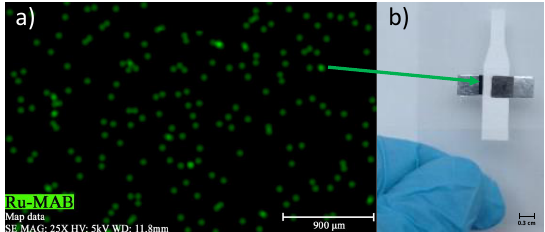
Figure 5. Fuel cell and material catalytic: ( a ) mapping of Ru, ( b ) micro-fuel cell photography.